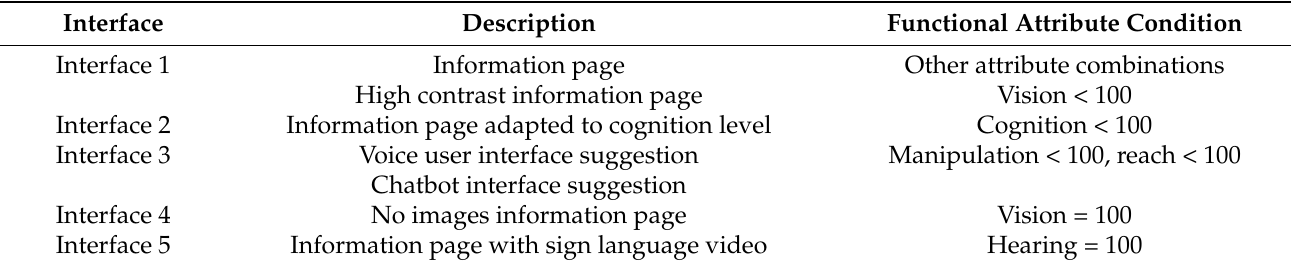
Table 6. User interfaces’ summary.